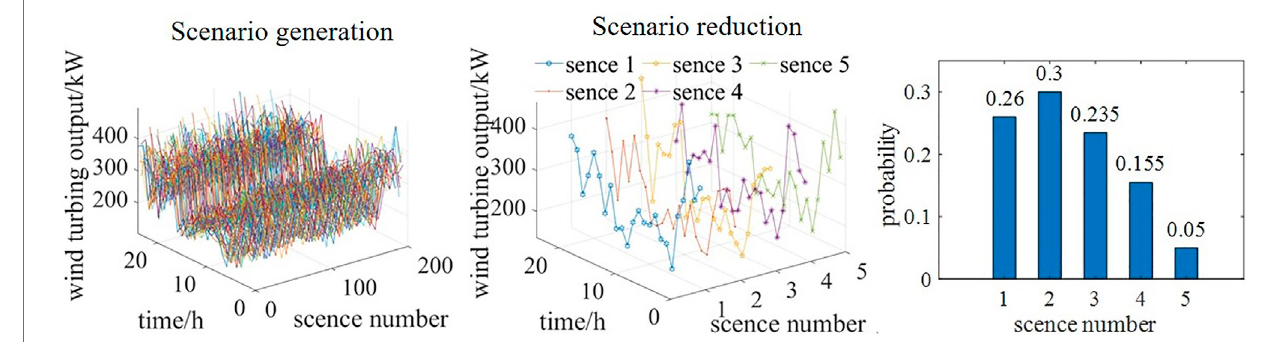
FIGURE 5 | Scenario generation and reduction of the wind turbine output curve in Case 4.